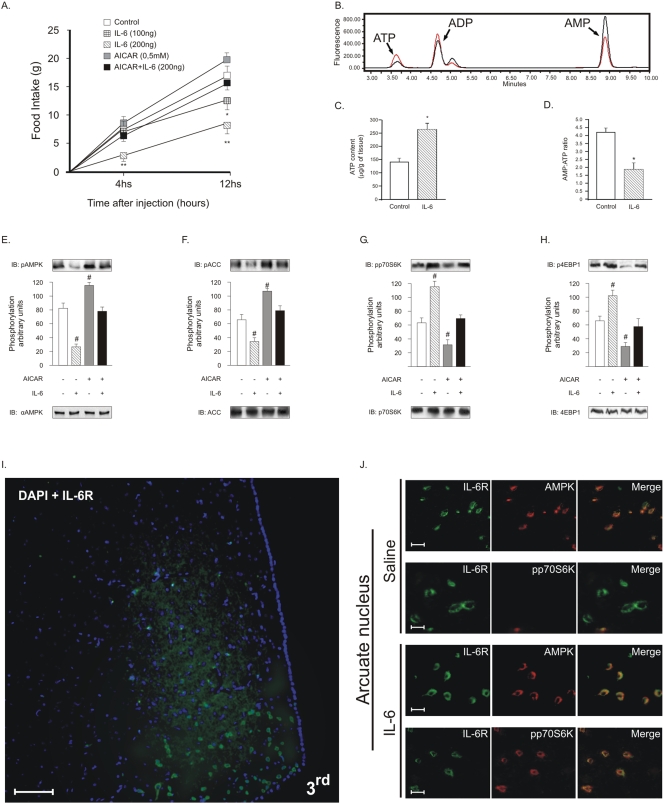
Effects of IL-6 on food intake, hypothalamic AMPK/mTOR activity and ATP content.(a) Effect of i.c.v. administration of IL-6 on food intake; pretreatment with AICAR blocks IL-6-induced anorexia (n = 12–15 animals per group). (b, c, d) Typical chromatographic run (b) depicting the ATP, ADP, and AMP fractions in control (black line) and in i.c.v. IL-6 treated animals (red line), as mean ATP content and as AMP∶ATP ratio (c, d). (e, f, g, h) Representative Western blots of four independent experiments showing hypothalamic lysates from Wistar rats. Phospho-AMPKthr172, threonine-phosphorylated AMPK and total AMPK (e); phospho-ACCser79, serine phosphorylated ACC and total ACC (f); phospho-p70S6Kinasethr389, threonine phosphorylated p70S6Kinase and total p70S6K (g); phospho-4EBP1thr70, threonine phosphorylated 4EBP1 and total 4EBP1 (h). Confocal microscopy was performed using IL-6 receptor (IL-6R)-specific antibody (green) and DAPI (blue), with 50× magnification (i). Co-localization of IL-6R (green) and AMPK (red) and IL-6R (green) and phospho-p70S6K (red) 60 minutes after i.c.v. saline or IL-6 infusion in the arcuate nuclei of rats, with 200× magnification (j). Data are the means±SEM. *p<0.05, vs. control group; **p<0.01, vs. control group; # p<0.05, vs. other groups.